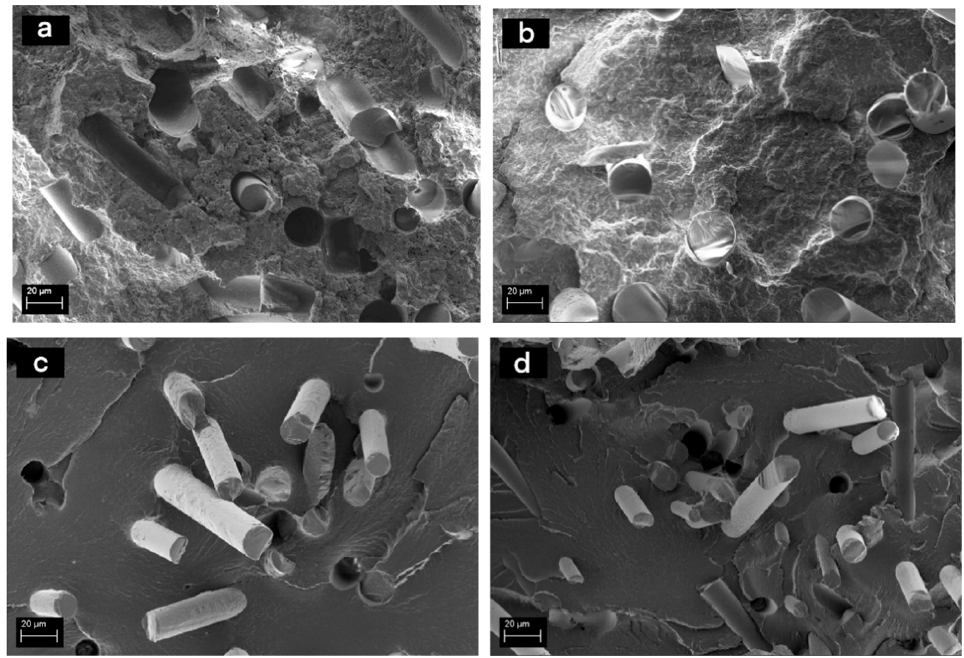
Figure 7. Fracture surfaces of ( a ) rGF-PP composite without fibre surface treatments, ( b ) rGF-PP composite after fibre sizing with 1 w-% PP-based sizing, ( c ) rGF-PA6 after fibre sizing with 5 w-% PU-based sizing and ( d ) rGF-PA6 after fibre sizing with 5 w-% PU-based sizing without rinsing.